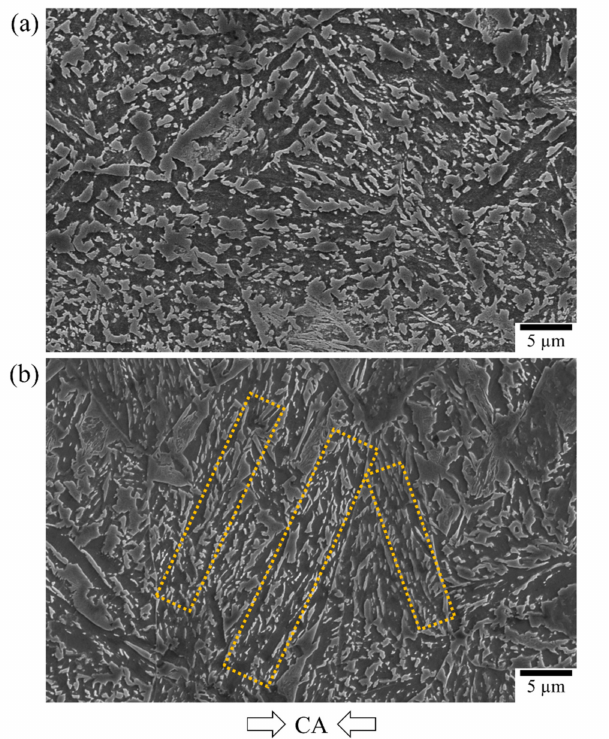
Figure 7. SEM micrographs of the processed samples—( a ) undeformed condition (isothermally formed at 500 ◦ C followed by continuous cooling to room temperature). ( b ) Deformed condition (dynamic transformation at 500 ◦ C followed by continuous cooling to room temperature). CA stands for the compression